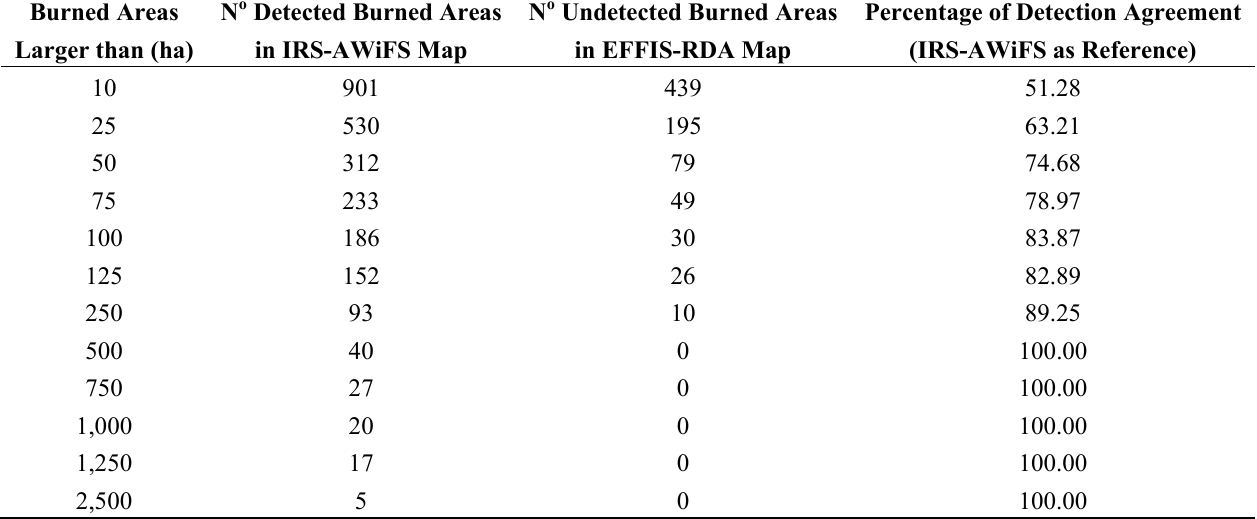
Table 3. Number of burned areas detected in MODIS-based EFFIS Rapid Damage Assessment (EFFIS-RDA) and IRS-AWiFS-based burned scar map. Burned Areas Larger than